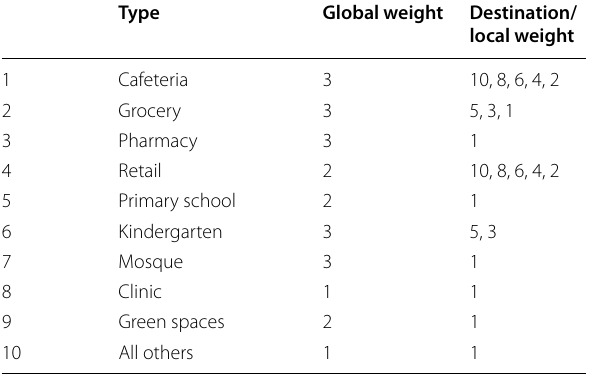
Table 2 Weighted amenities in the studied